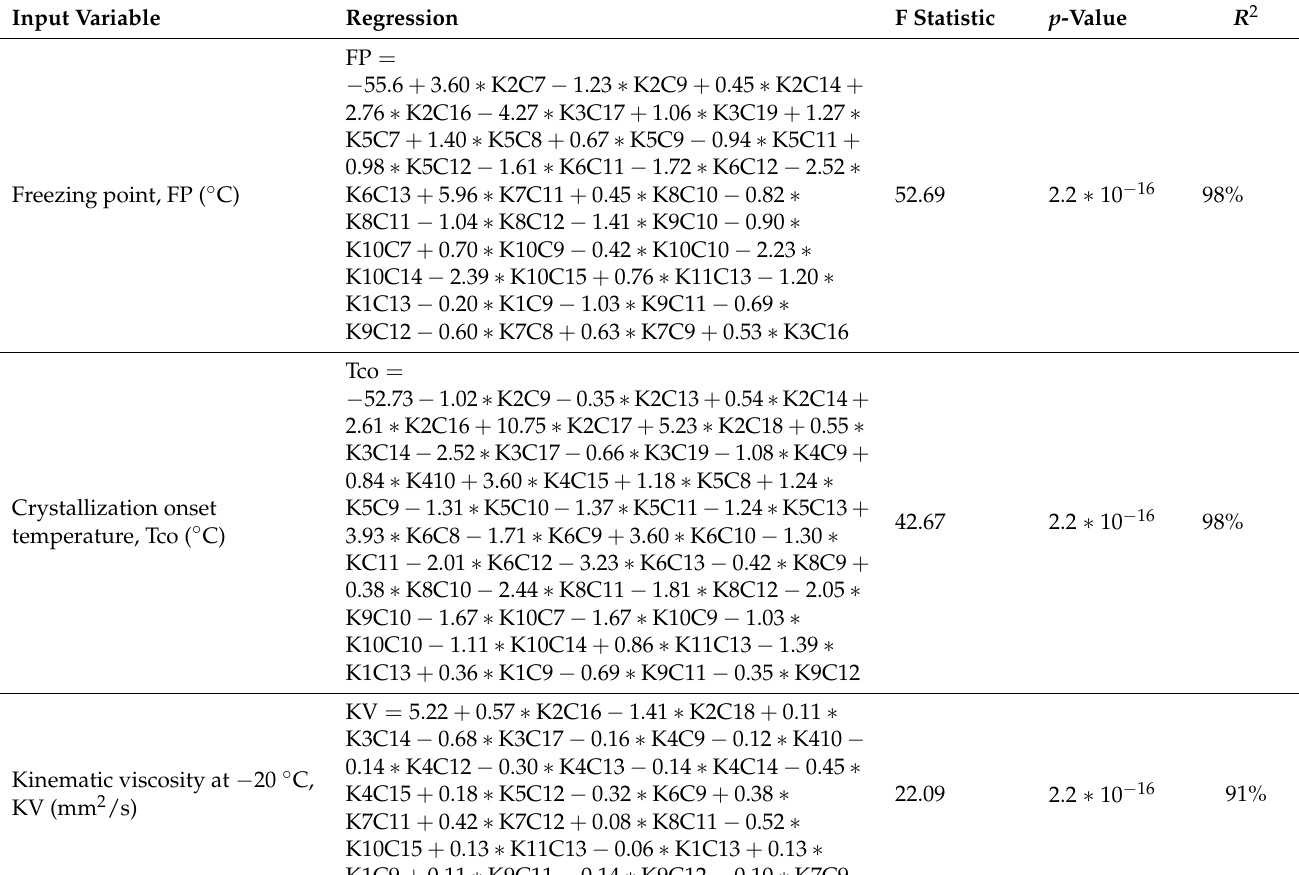
Table 7. Linear regression models for fluidity properties as a function of weight fraction of hydrocarbon